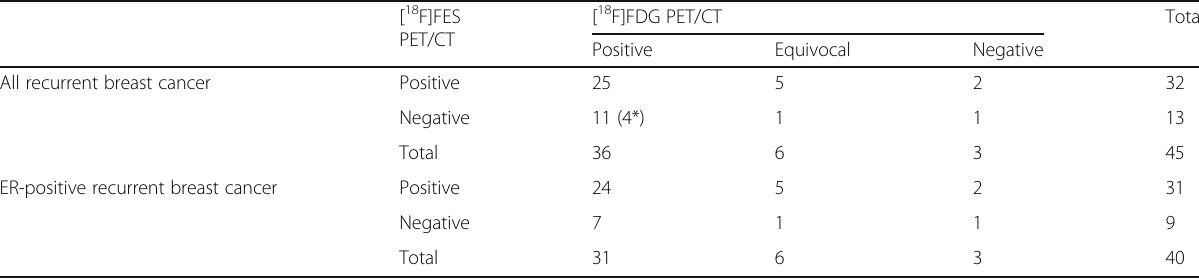
Table 2 Qualitative interpretation of [ 18 F]FES and [ 18 F]FDG